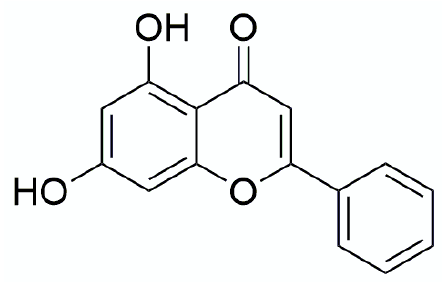
Figure 1. The chemical structure of chrysin.